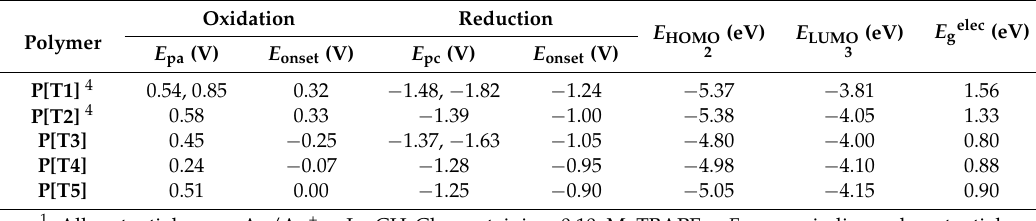
Table 3. Electrochemical data for polymer films of P[T1] – P[T5] .